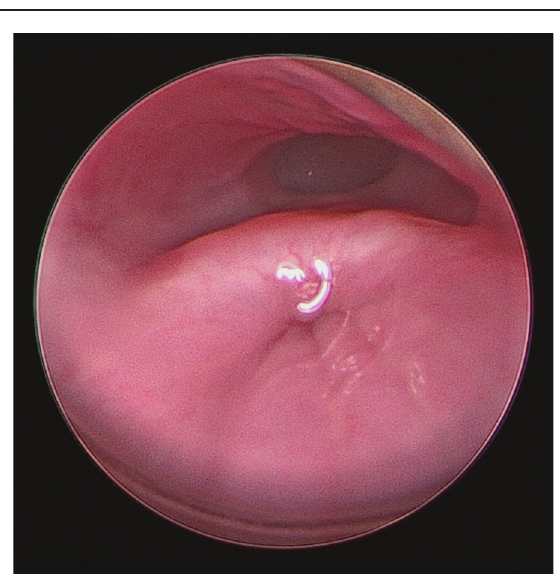
Endoscopic image during telescopic examination. Fistula seen at 2.5cm from